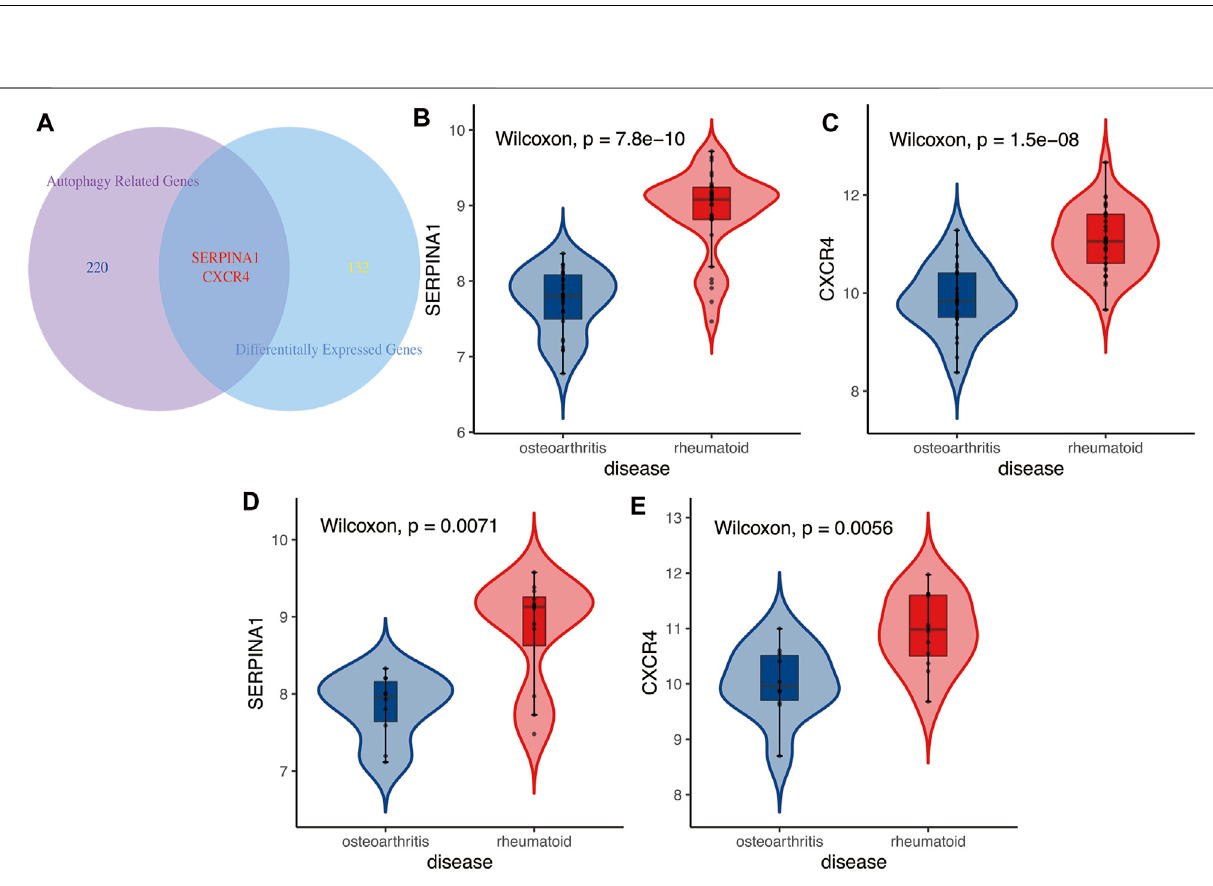
Frontiers in Genetics |